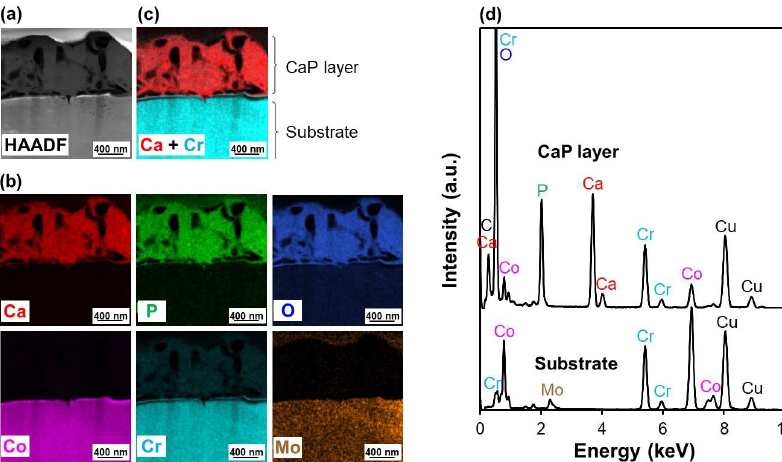
Figure 7. ( a ) High-angle annular dark field (HAADF) image, ( b ) scanning TEM (STEM)-EDX elemental (Ca, P, O, Co, Cr and Mo) maps and ( c ) STEM-EDX merged elemental (Ca + Cr) map of the ultra-thin cross-section of the LAB-processed (30 min) Co−Cr alloy substrate (CaP-coated surface). ( d ) STEM-EDX spectra obtained from each region in ( c ). The Cu peaks in ( d ) are derived from the grid that was used to mount the cross-sectional ultra-thin sample, and the C peak in ( d ) is derived from the oil-based ink (soft protective cover) that was applied to the substrate surface prior to the FIB processing.